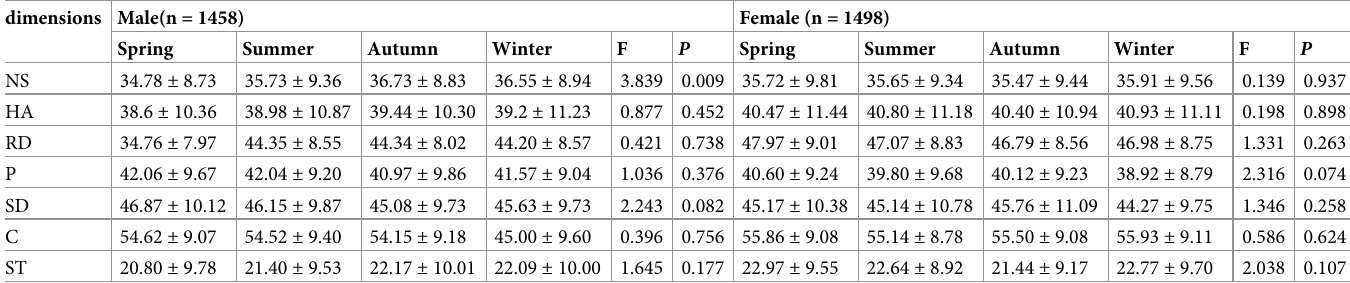
Table 2. The mean differences between TCI dimensions and seasons by gender. dimensions Male(n =